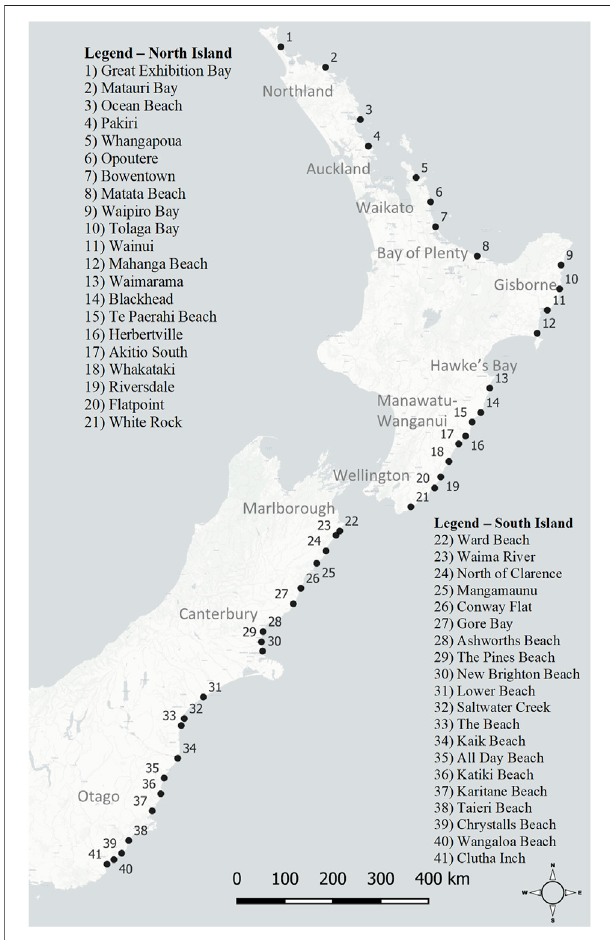
FIGURE 1 | New Zealand Beaches Sampled for Anthropogenic Marine Debris ( > 2 mm) (Spring 2017).